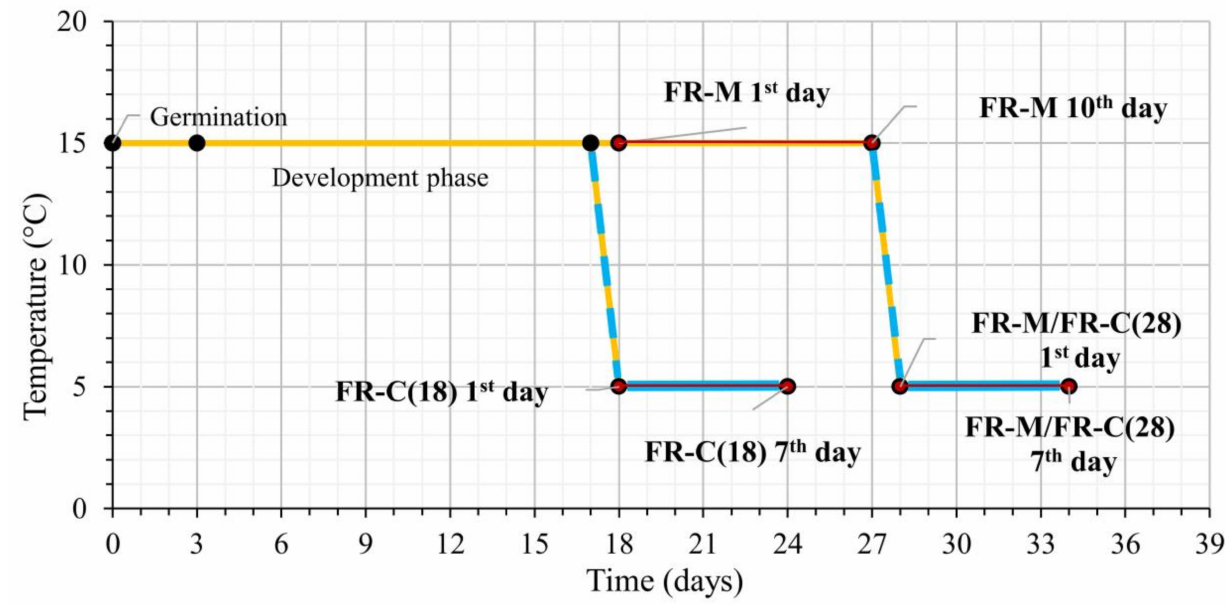
Figure 1. The experimental set-up describing the light and temperature treatments. Treatment 1 (FR-M): The plantlets were exposed to high far-red (FR) at the age of 18 days under constant 15 ◦ C for 10 days. Treatment 2 (FR-M/FR-C(28)): The plantlets were subjected to high FR for 10 days at 15 ◦ C, then the temperature was dropped to 5 ◦ C for another seven days (at high FR). Treatment 3 (FR-C(18)): The plantlets were 18 days old when the temperature was dropped to 5 ◦ C for seven days (at high FR). The red lines represent the FR treatments, while the blue lines indicate the low temperature 5 ◦